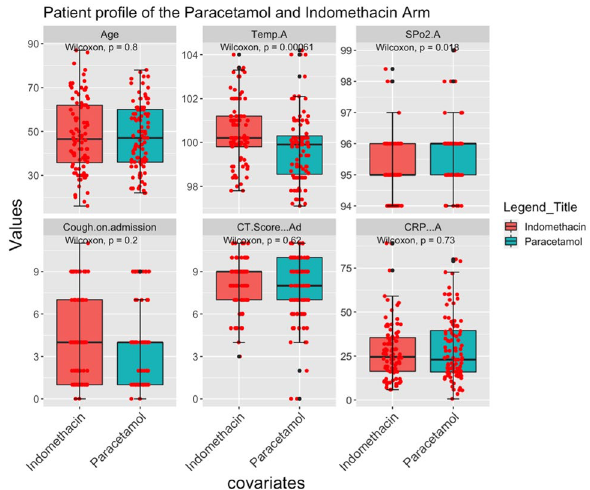
Figure 2. Patient profile on